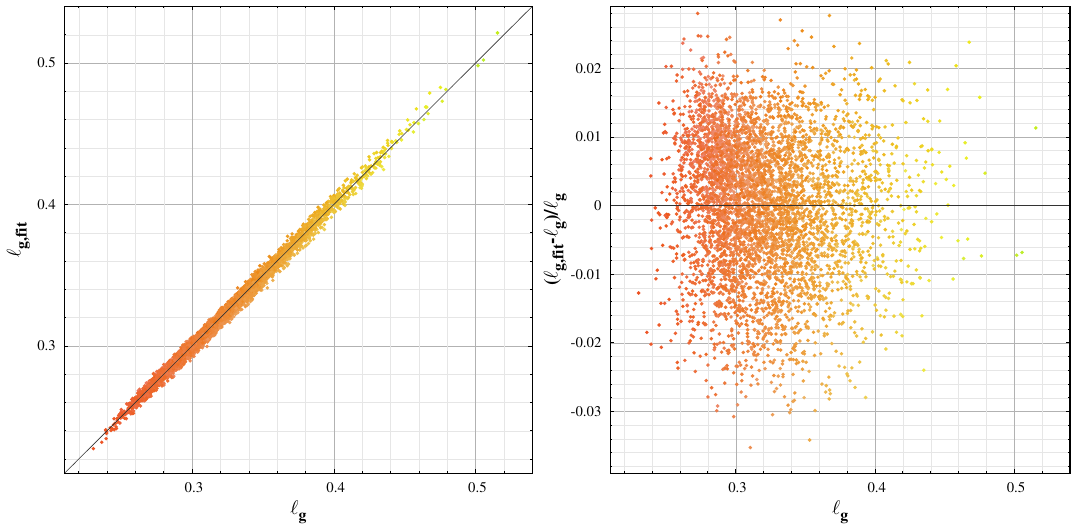
Figure 6. The quality of the colour conversion for the green channel. Left box : the fitted versus original (cid:96) g coordinates, right box : the error of the fit. The dots represent the actual